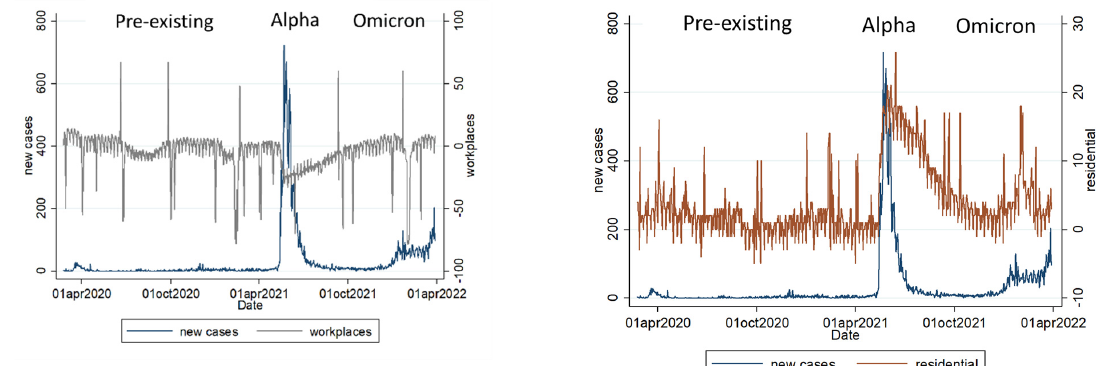
Figure 2. Population visits change of various places well correlated with daily new confirmed cases per million people (7-day rolling average) in Taiwan during the main three wave COVID-19 epi- demics.